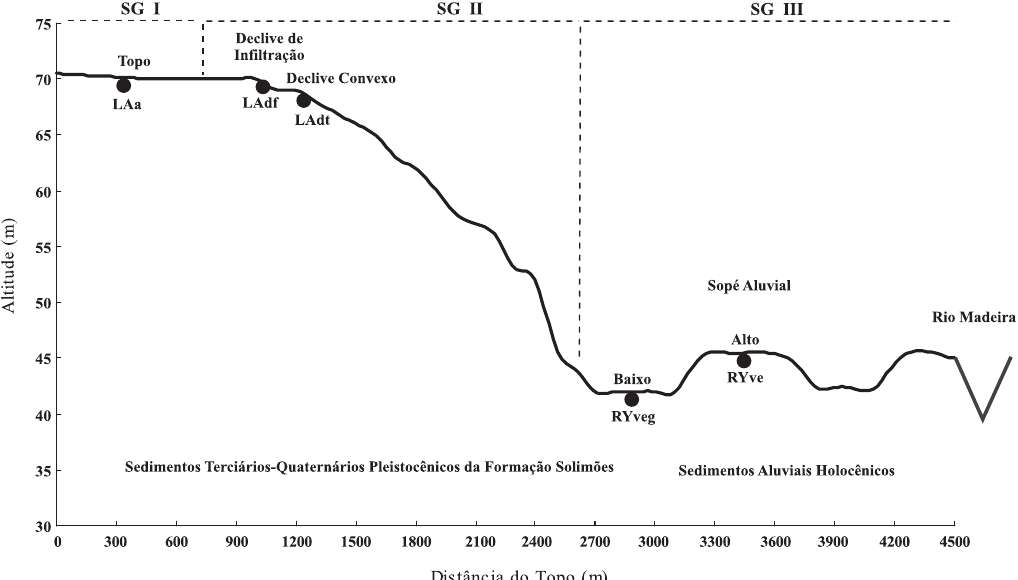
figura 1. perfil topográfico, superfícies geomórficas, segmentos de vertente e respectivas classes de solos, em um ambiente várzea/terra firme, na região de Humaitá (am). sG i, sG ii e sG iii = superfícies geomórficas i, ii e iii,